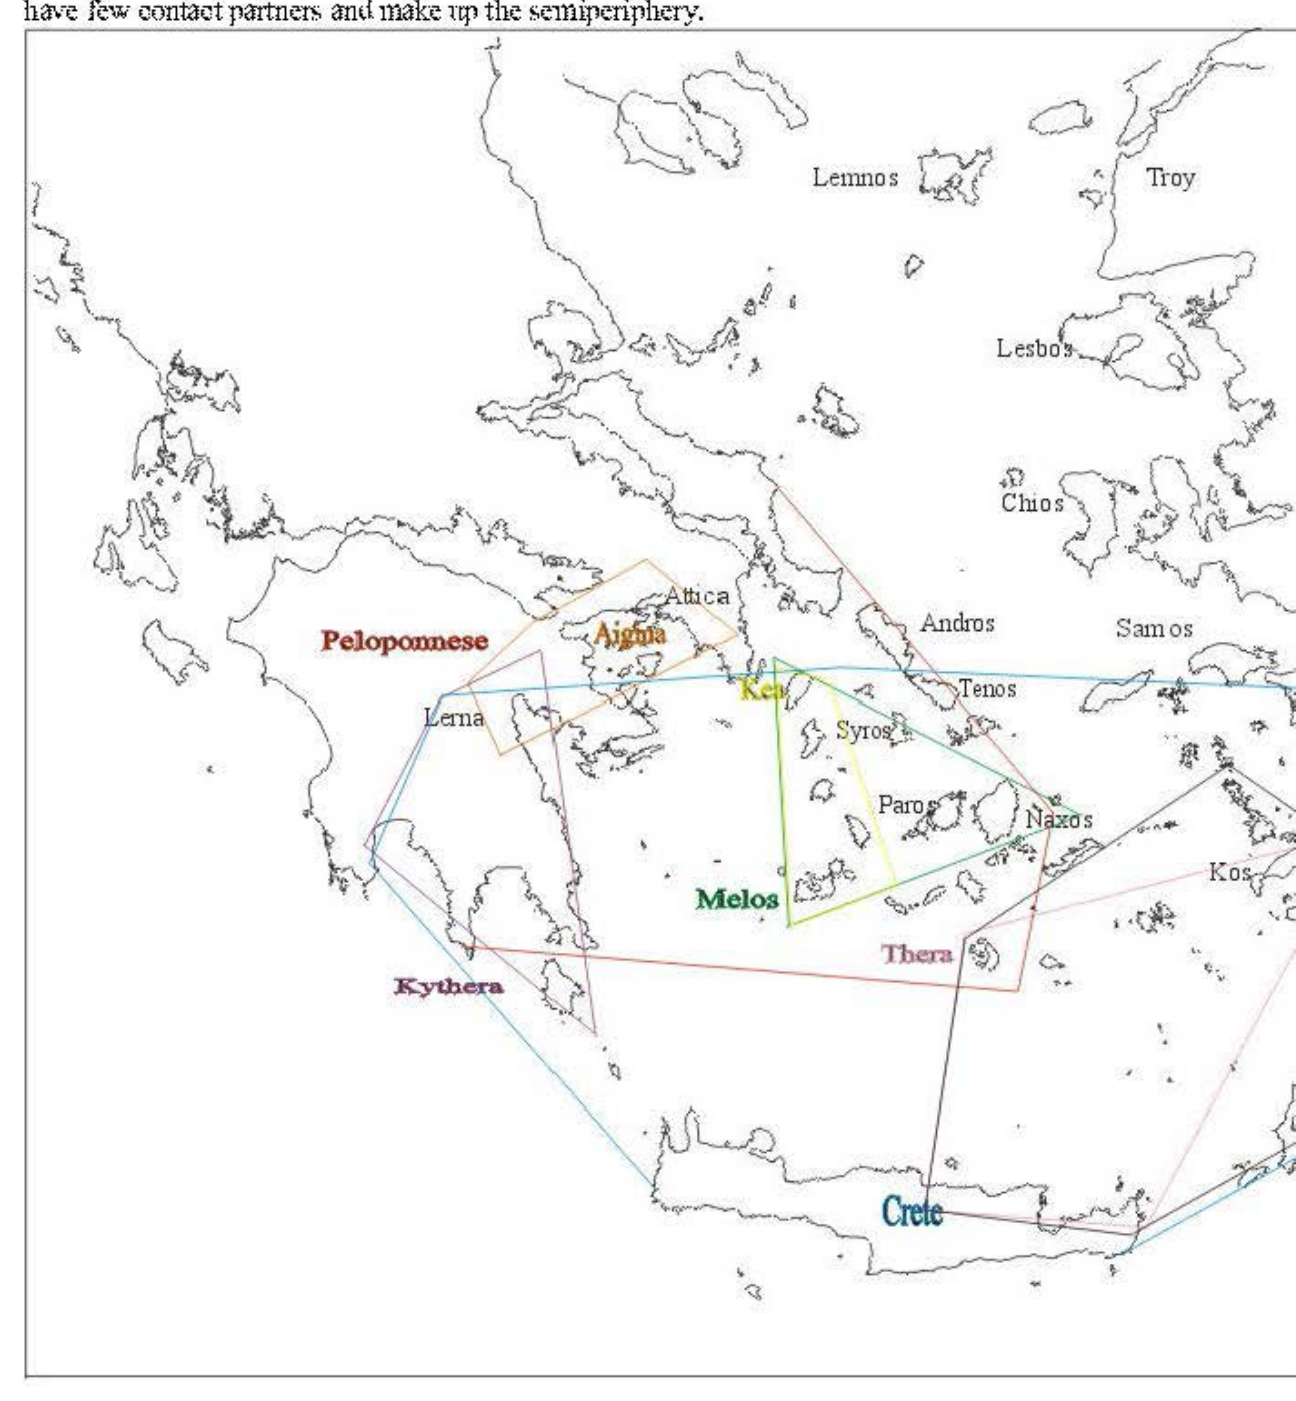
Map 2b: LCI Regional Exchange